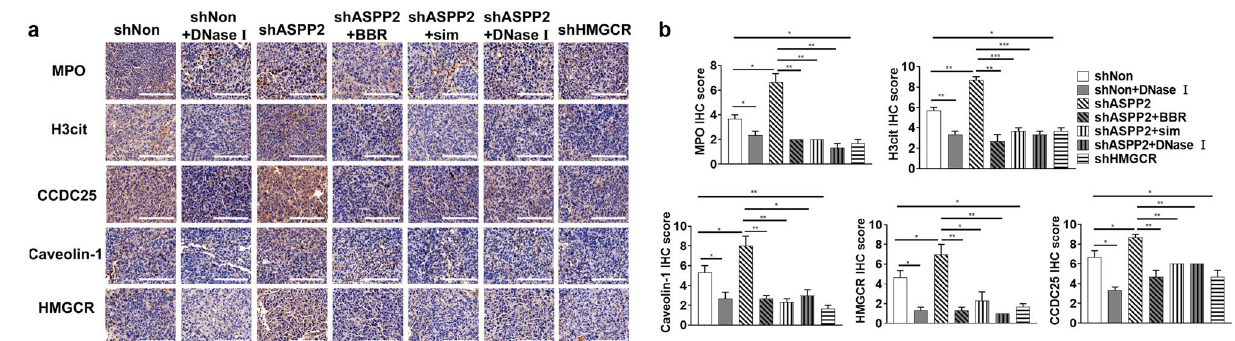
Figure 7. Immunohistochemical staining in lung metastases. ( a ) Representative images of IHC assays for H3cit, MPO, Caveolin-1, CCDC25 and HMGCR of lung tissues from indicated mice as in Fig. 4. Scale bar: 200 µm. ( b ) Statistical analysis of IHC scores. * P < 0.05; ** P < 0.01; *** P < 0.001. Data were presented as means ±